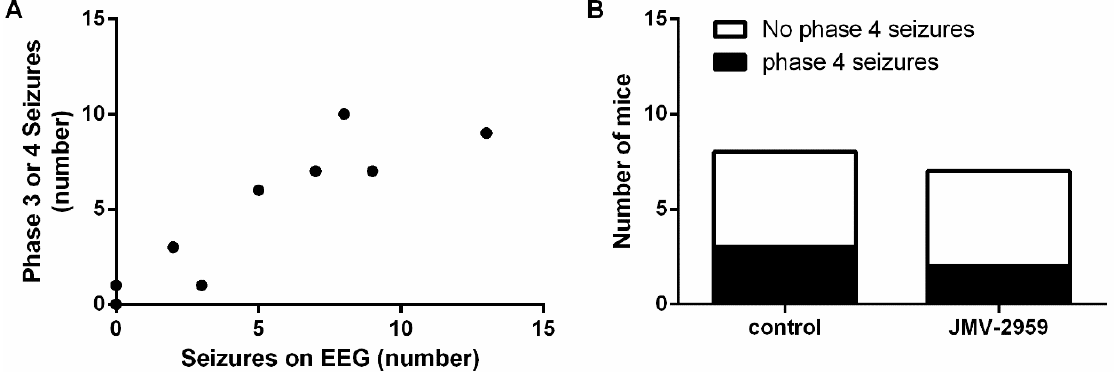
Figure 7. JMV-2959-treated mice experience a similar amount of Phase IV seizures. ( A ) Correlation between number of Phase III and IV seizures visually observed and number of hippocampal discharges on EEG (controls and JMV-2959-treated mice taken together; n = 10 pairs). Pearson correlation ( p < 0.001; Pearson’s r = 0.9144). ( B ) Twenty-nine percent of JMV-2959-treated mice ( n = 7) experienced Phase IV seizures and 38% of saline-treated controls ( n = 8) did. Fisher’s exact test ( p > 0.05). EEG, electro-encephalography.